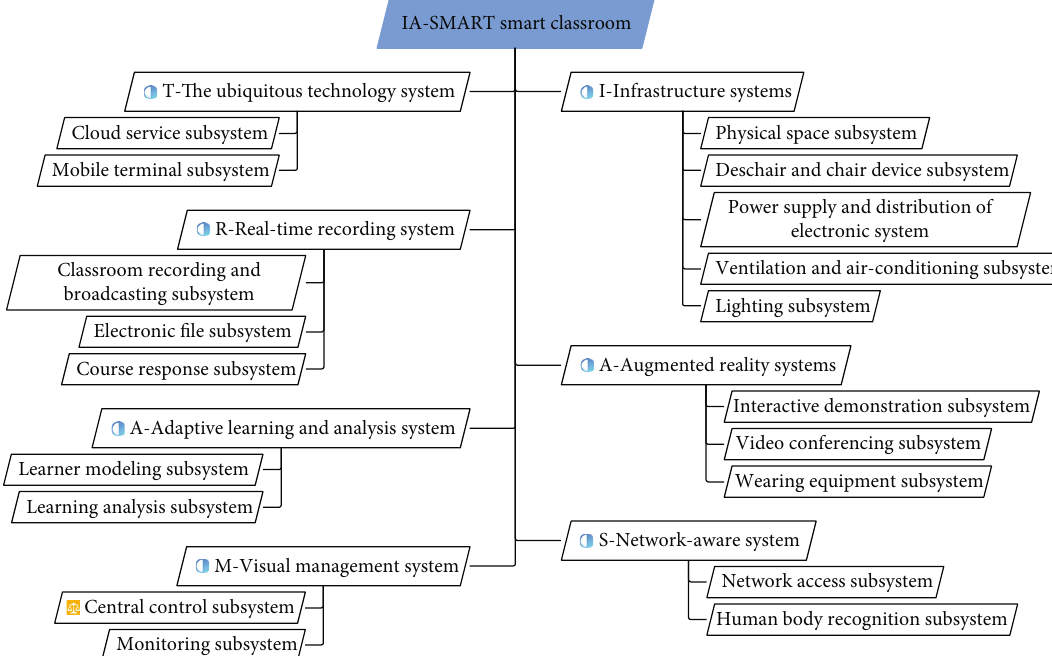
Figure 7: Smart classroom system model based on Internet of Things and big data technology.